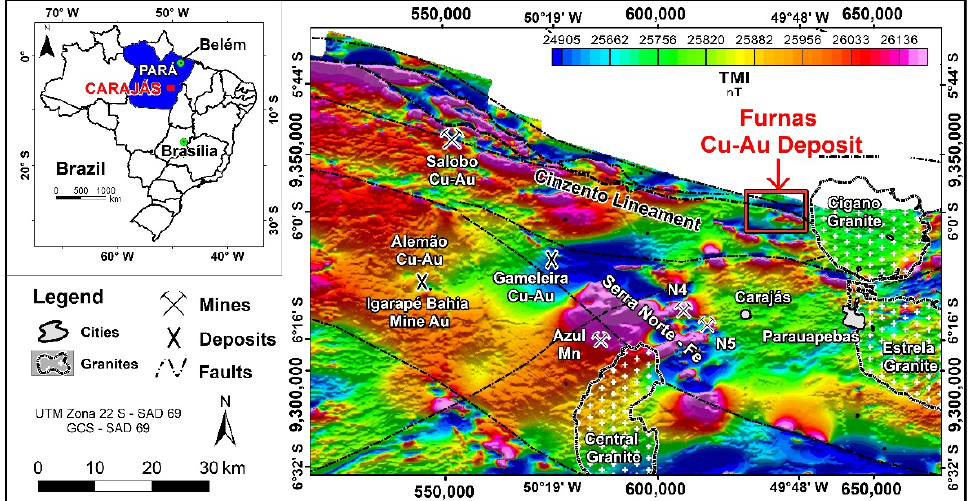
Figure 2. Total magnetic intensity of Carajás Mineral Province with the location of the Furnas deposit along the Cinzento lineament, mines, deposits, granites, and main faults.